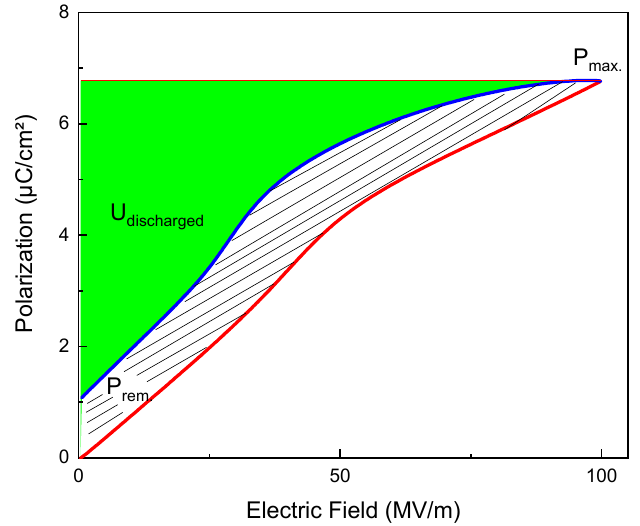
Figure 1. A unipolar polarization hysteresis loop. The green area corresponds to the recoverable energy density. The hatched area yields losses in the storage process.